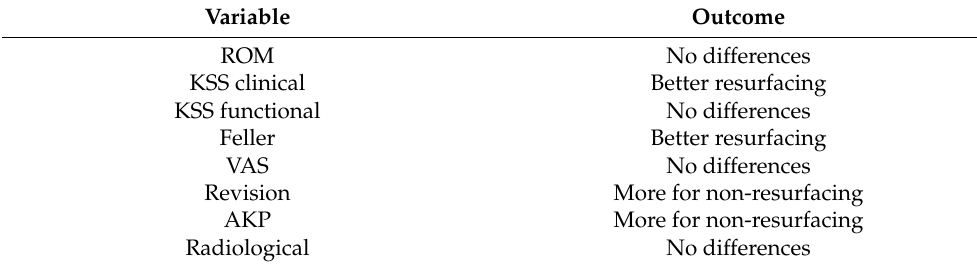
Table 3. Summary of